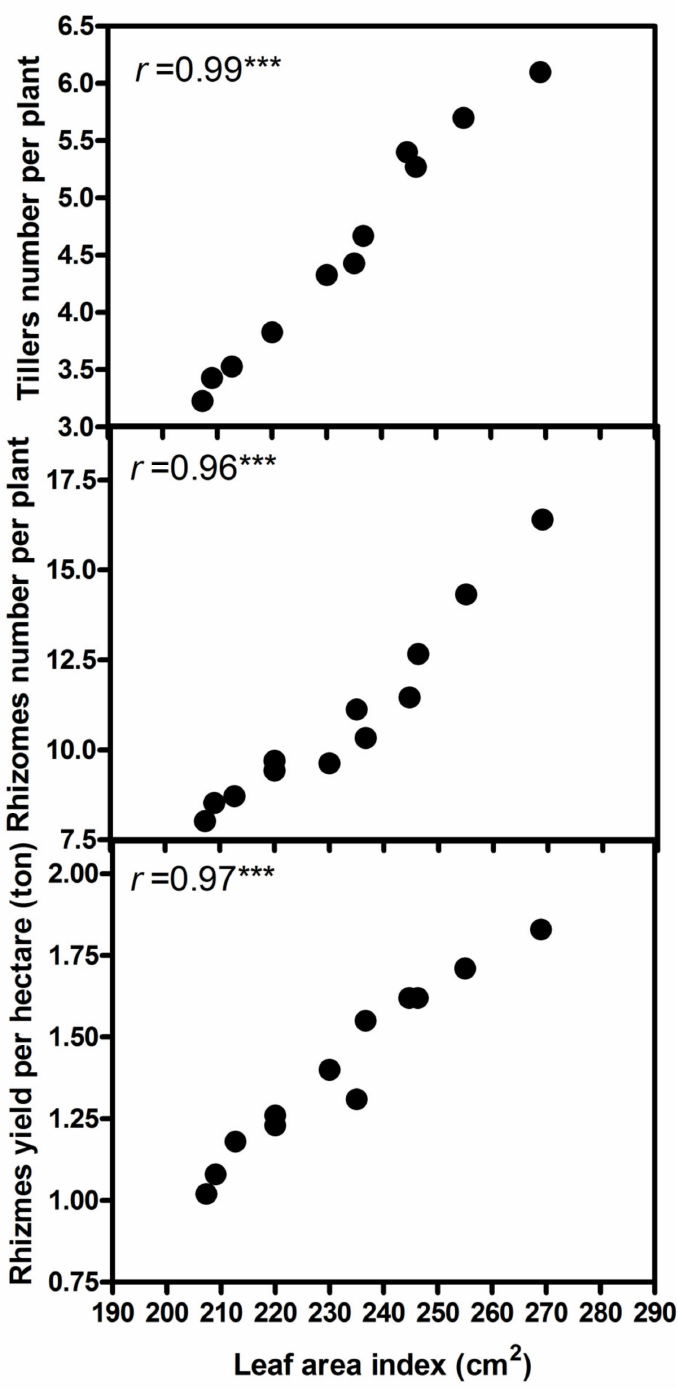
Figure 5. Coefficient correlation of leaf-area index and tiller number per plant, rhizome number per plant and rhizome yield per hectare. *** Significance at probability level of <